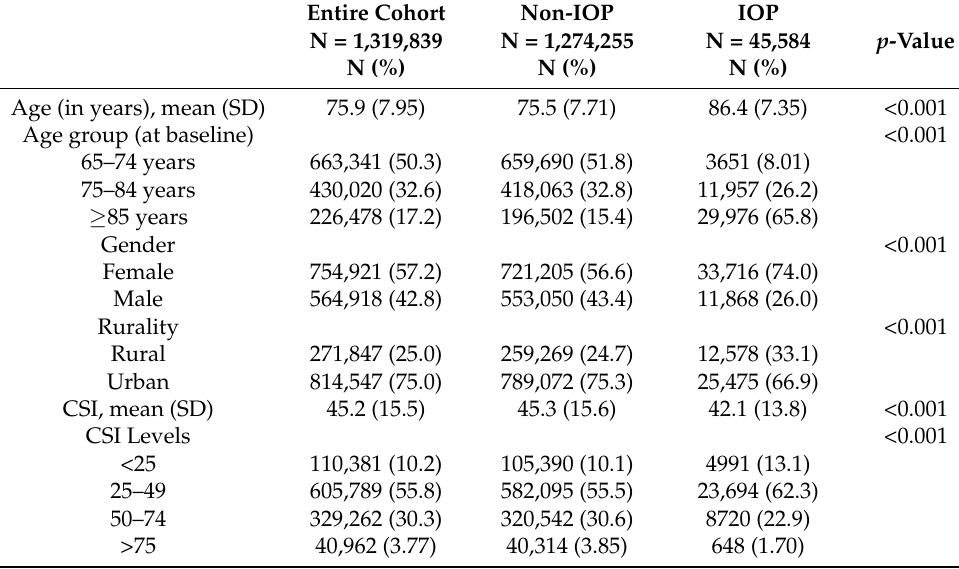
Table 2. Comparison of participant characteristics according to whether they were institutionalised (IOP) or